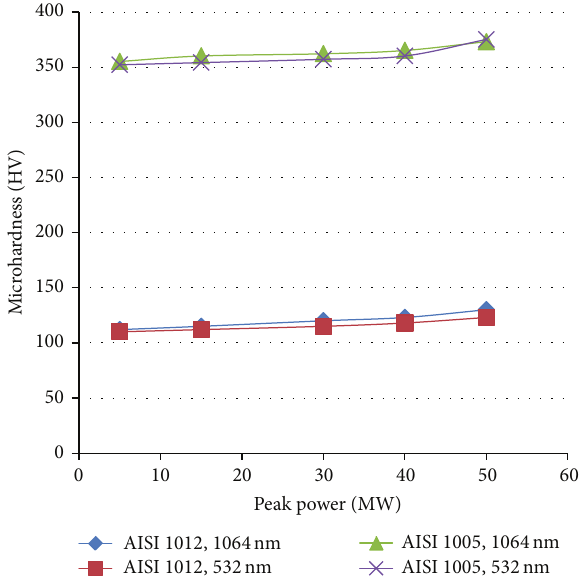
Figure 6: Variation of microhardness as a function of 𝑃 𝑝 at PRR 4